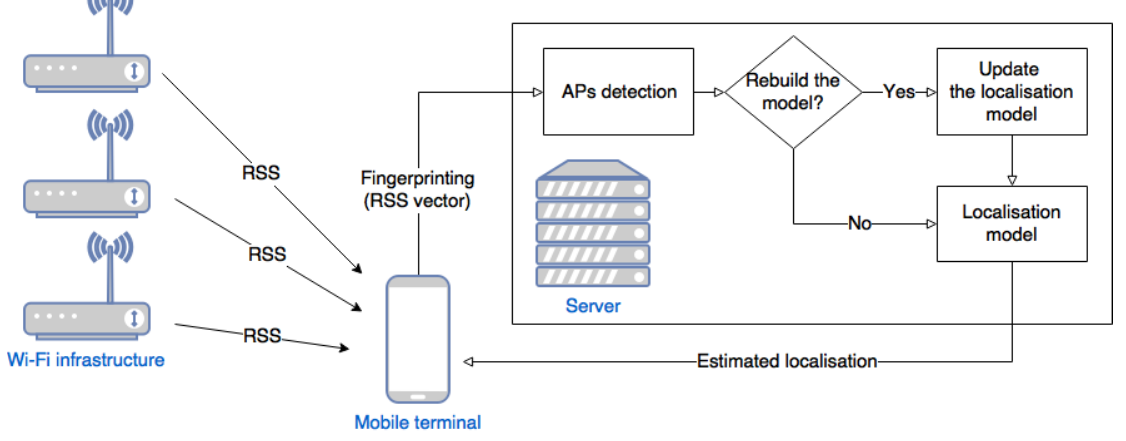
Figure 5. Localisation